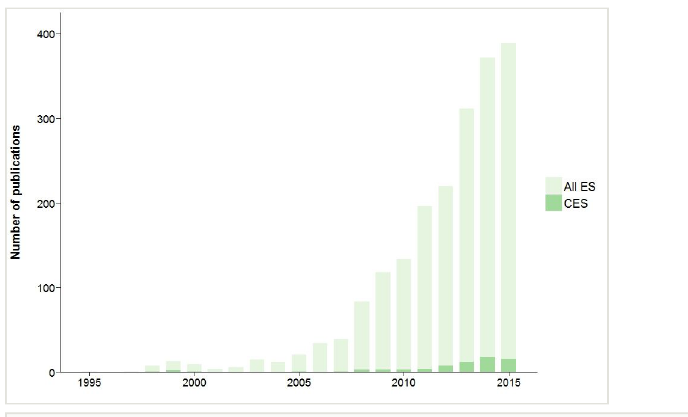
Figure 2. Number of publications about marine and coastal ecosystem services. The fi gure compares the number of publications on all marine and coastal ecosystem services categories (All ES), i.e., provisioning, regulating and cultural, and the number of publications only about marine and coastal CES, between 1995 and